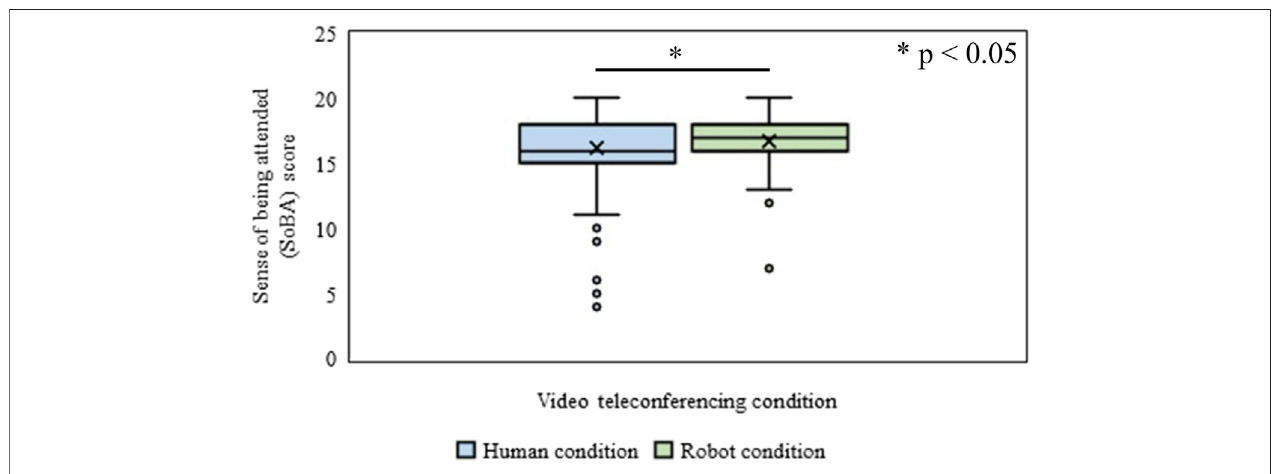
FIGURE 11 | Sense of being attended (SoBA) in Human and Robot conditions of Experiment- Ⅱ